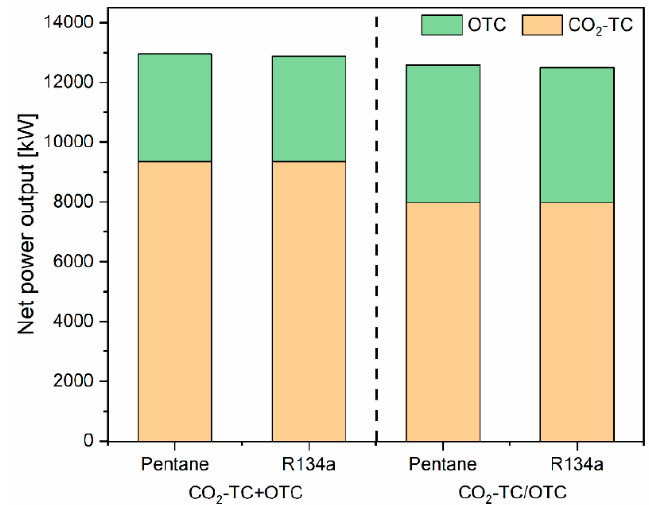
Figure 13. Net power output comparison of the two combined cycles.